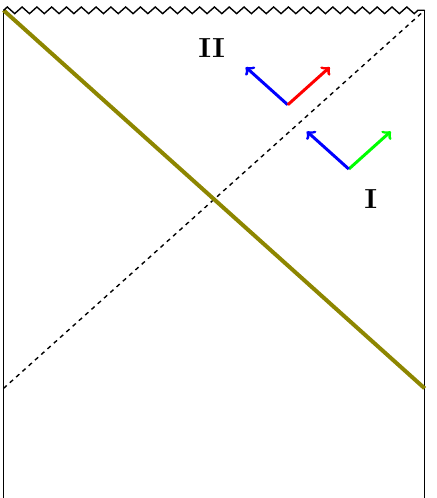
Figure 8: Bulk reconstruction fails for a collapsing black hole. The left moving mode (in blue) can be continued back to the boundary but the right moving mode (in red) inside the horizon when continued back collides with the infalling null shell (in olive) at transplanckian